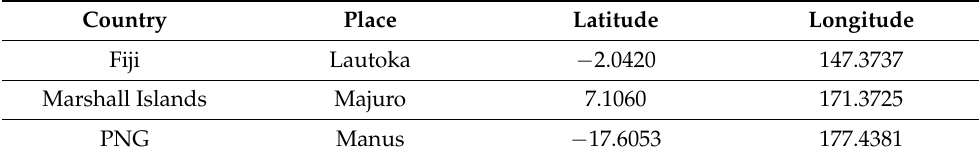
Table 1. Description of the location of variables for MSL forecasting. Country